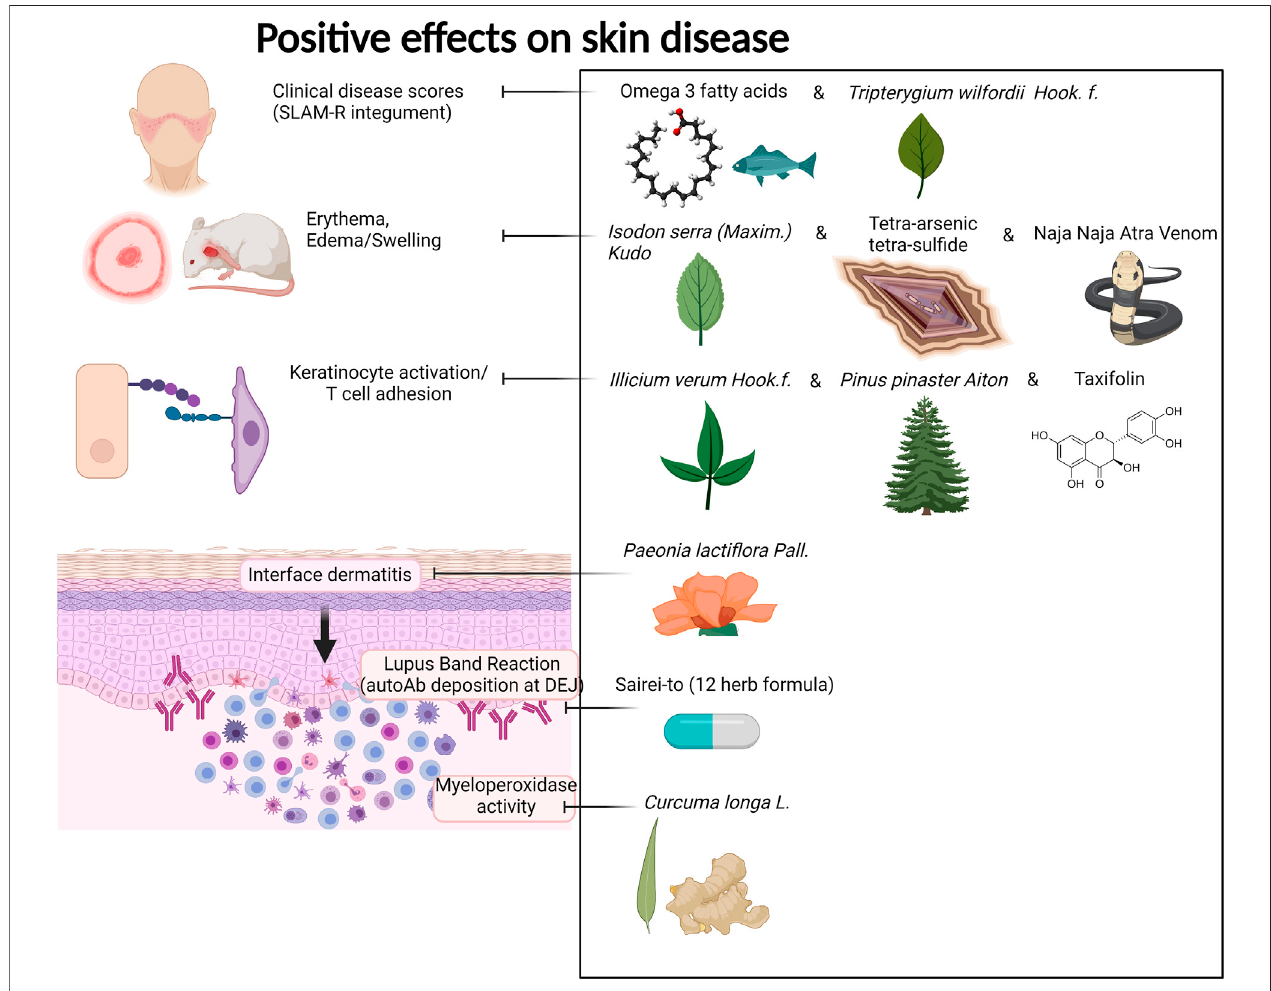
FIGURE 4| Compounds with positiveeffectson skin disease.Omega 3 fatty acids and Tripterygium wilfordii Hook. f. demonstrated positive effects on clinical skin diseaseinCLEandSLEpatients. Isodonserra(Maxim.) Kudô ,tetra-arsenictetra-sul fi de,and NajaNajaAtraVenomexhibitedpositiveeffectsonerythemaandedemain mouse models oflupus. Illicium verum Hook. f., Pinus pinaster Aiton , and the active compoundtaxifolin, which can be isolated from these plants, demonstrated positive effects on keratinocyte activation and T cell adhesion in in vitro and in vivo mouse assays. Paeonia lacti fl ora Pall. demonstrated positive effects on interface dermatitis,andSairei-to(12-herbformula)preventedlupusbandreaction.Last, CurcumalongaL. (curcumin,turmeric)reducedmyeloperoxidaseactivityofgranulocytes in the skin. Created with BioRender.com.